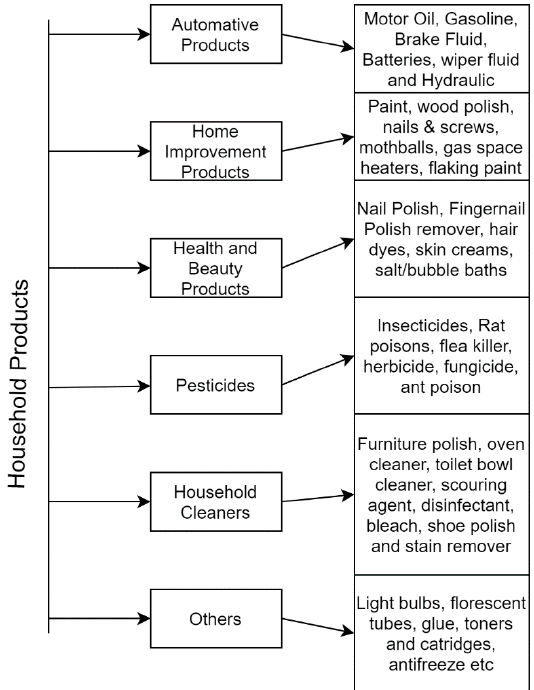
Figure 5. Household Hazardous Waste Materials